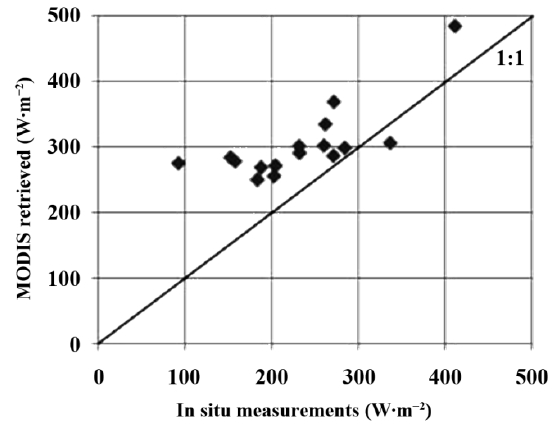
Figure 4. Relationship of latent heat fluxes retrieved from MODIS and in-situ eddy covariance